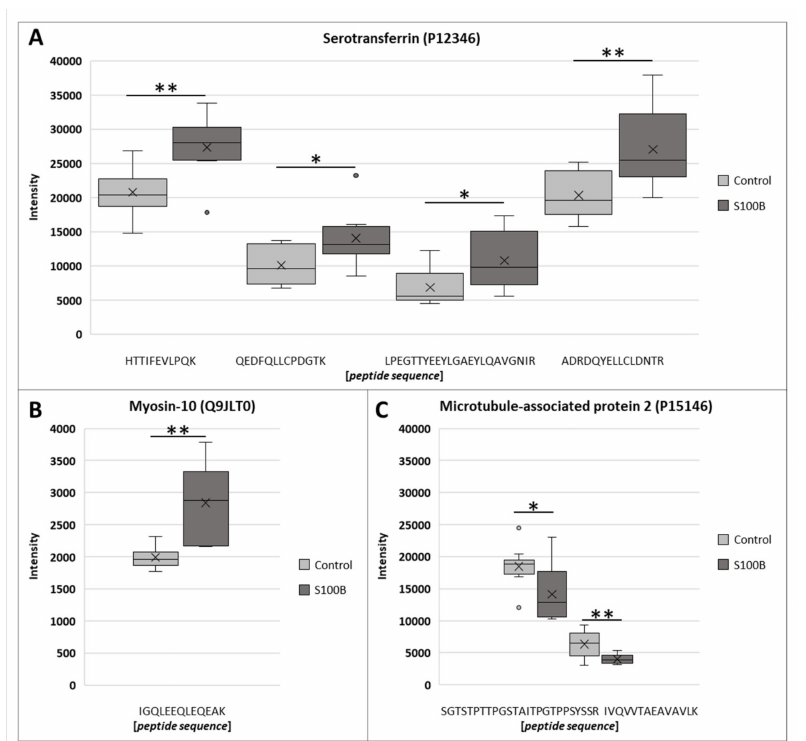
Figure 3. Mass spectrometry-based intensities of differential peptides with their assigned proteins 7 days after S100B injection. ( A ) Four unique peptides associated with serotransferrin and ( B ) one unique myosin-10 peptide were significantly up-regulated in rat retinae, 7 days after S100B immu- nization. ( C ) In contrast, two unique peptides of microtubule-associated protein 2 were significantly down-regulated in in rat retinae, 7 days after S100B immunization (* p < 0.05, ** p ≤ 0.01, ratio > 30%). In Figure 4, all identified peptides belonging to the protein gephyrin are shown. Re- cently, a significantly lower inhibitory post-synapse signal was visualized by anti-gephyrin